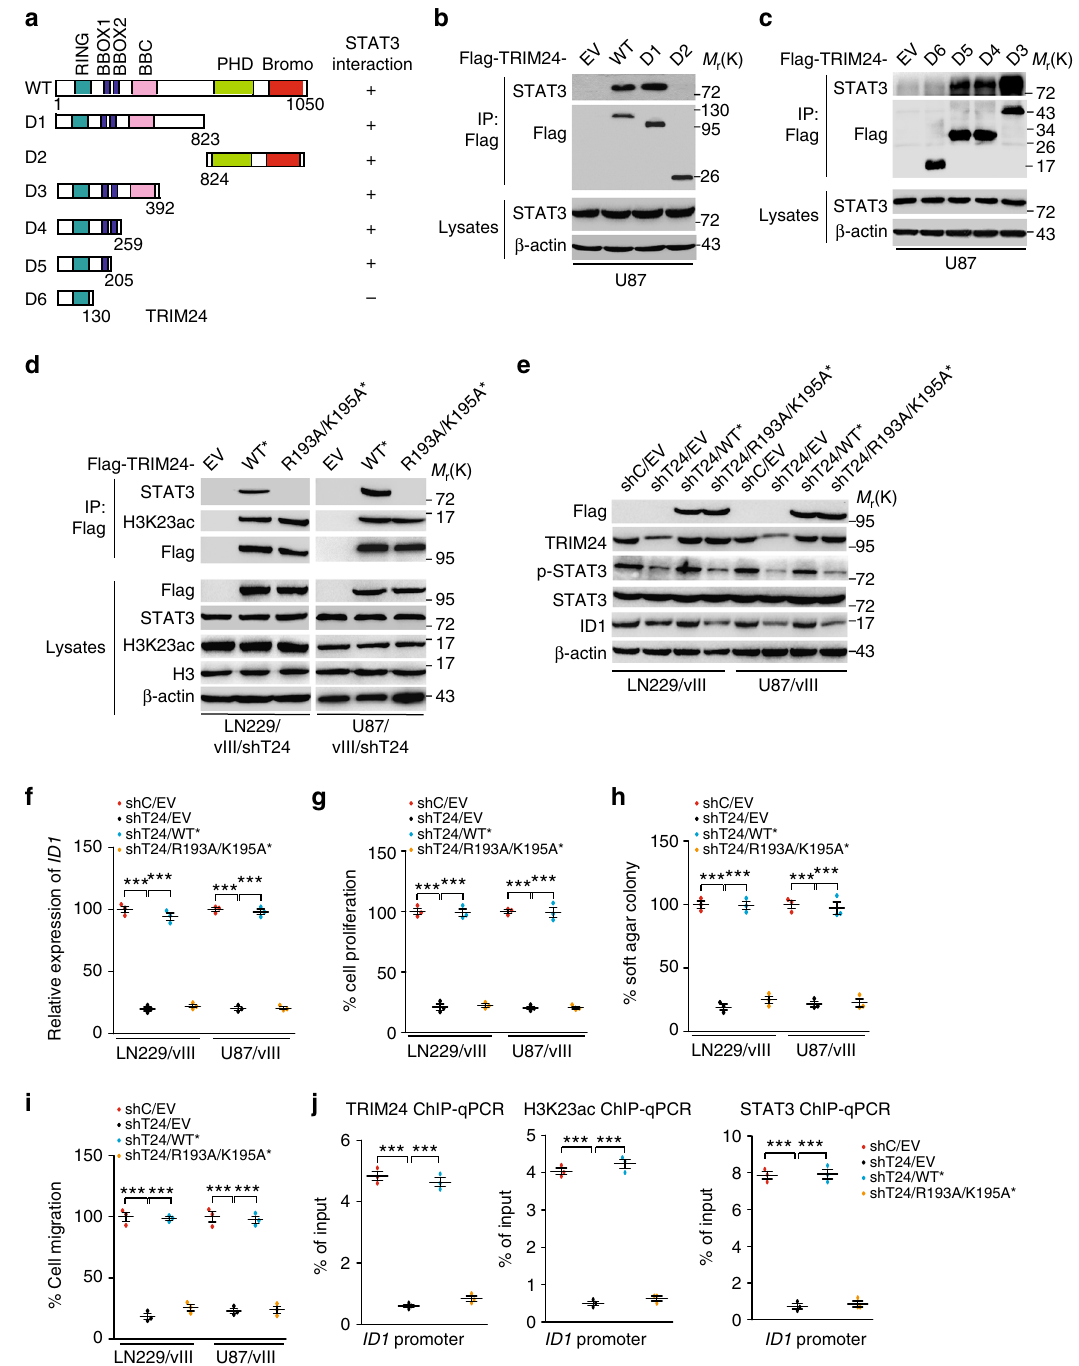
Fig. 7 R193/K195 sites are necessary for TRIM24 to bind with and recruit STAT3 to chromatin. a Schematics of TRIM24 WT and various TRIM24 deletion constructs. b , c STAT3 interacts with TRIM24 through its BBOX1 domain with amino acid residues 131 – 205. TRIM24 WT or the indicated TRIM24 mutants were transfected into U87 GBM cells. d Re-expression of shRNA-resistant Flag-tagged TRIM24 WT* , but not TRIM24 R193A/K195A* mutant or an empty vector control (EV), resulted in binding between TRIM24 and STAT3 in LN229/vIII/shT24 and U87/vIII/shT24 GBM cells. e Effects of re-expression of shRNA-resistant Flag-tagged TRIM24 WT* , TRIM24 R193A/K195A* mutant, or an empty vector control (EV), on STAT3 phosphorylation and ID1 protein expression. f qRT-PCR analysis of effects of re-expression of shRNA-resistant TRIM24 WT* , TRIM24 R193A/K195A* mutant or an empty vector control (EV) on ID1 mRNA expression. g – i Effects of re-expression of shRNA-resistant TRIM24 WT* , TRIM24 R193A/K195A* mutant or an empty vector control (EV) on cell proliferation g , colony formation in soft agar h , and cell migration i . j ChIP-qRT-PCR analyses of effects of re-expression of shRNA-resistant TRIM24 WT* , TRIM24 R193A/K195A* mutant or an empty vector control (EV) on the binding of TRIM24, STAT3 and H3K23ac with the ID1 promoter. Error bars, s.d. Data represent two or three independent experiments with similar results. *** P < 0.001, paired two-way Student ’ s t -test, compared with EGFRvIII cells treated with